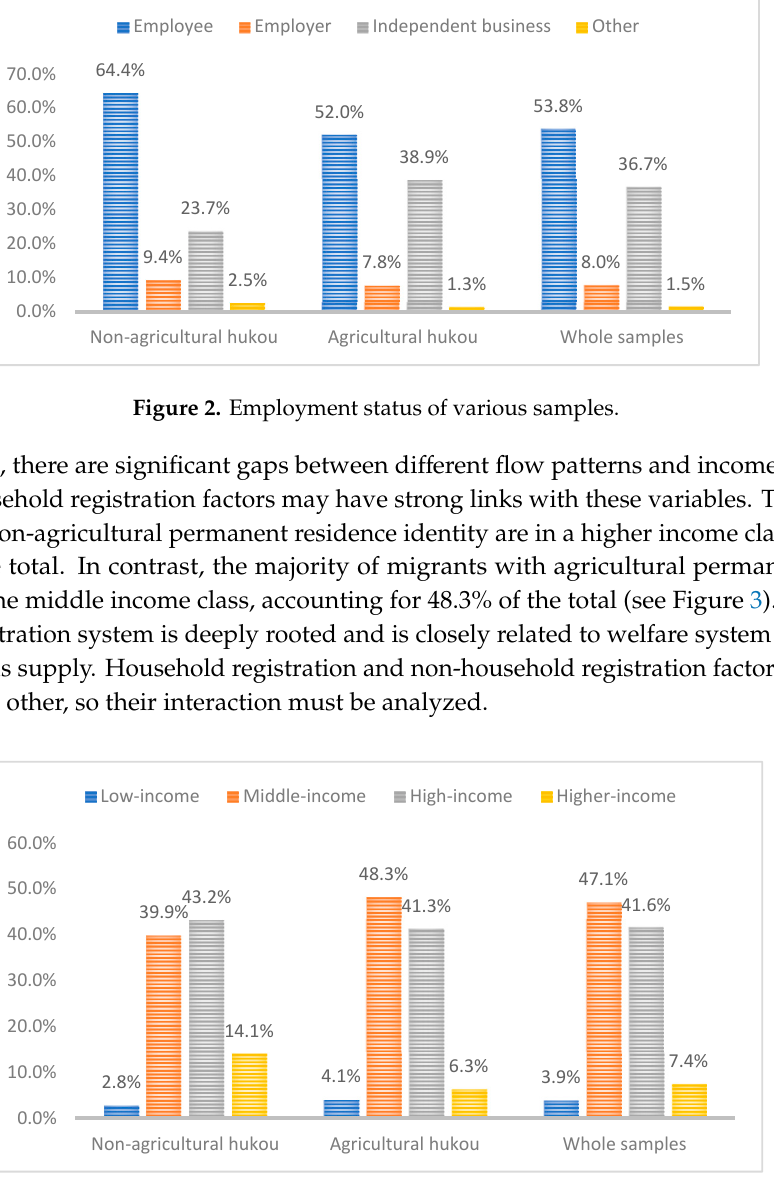
Table 2. Binary logistic results. Dependent Variable